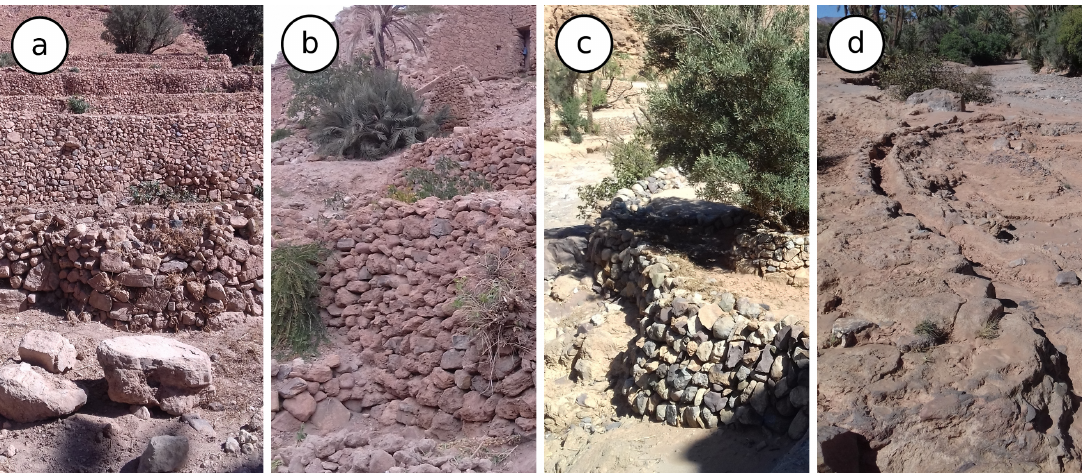
Figure 2. Documentation of the dry stone structures: ( a ) terraces on a slope, in the foreground a recountouring of the wall in a place broken by a palm tree currently removed, ( b ) a dry wall with adult plants of Capparis spinosa consolidating it, ( c ) dry wall structure on the wadi banks, ( d ) abandoned ancient irrigation channel, crossing the wadi to irrigate the opposite bank.